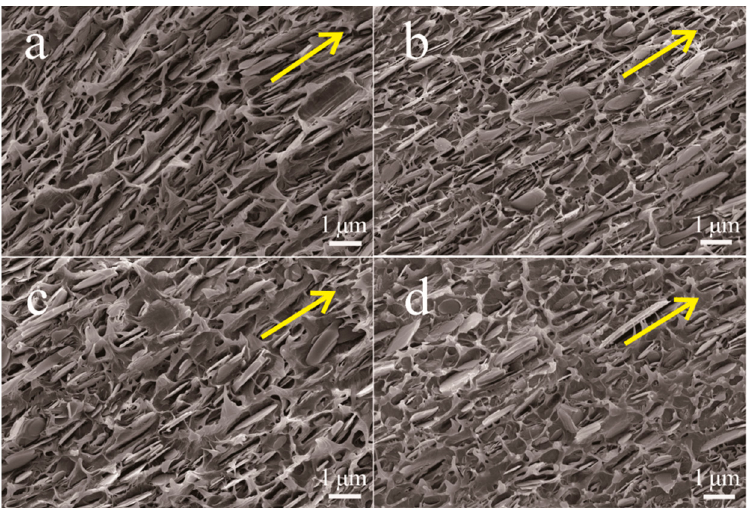
Figure 4. SEM images of the freeze-fractured cross-section surfaces of ( a ) BNNSs/PVDF; ( b ) BNNSs@C-5/PVDF; ( c ) BNNSs@C-15/PVDF; and ( d ) BNNSs@C-45/PVDF nanocomposites at 20 vol % fi ller